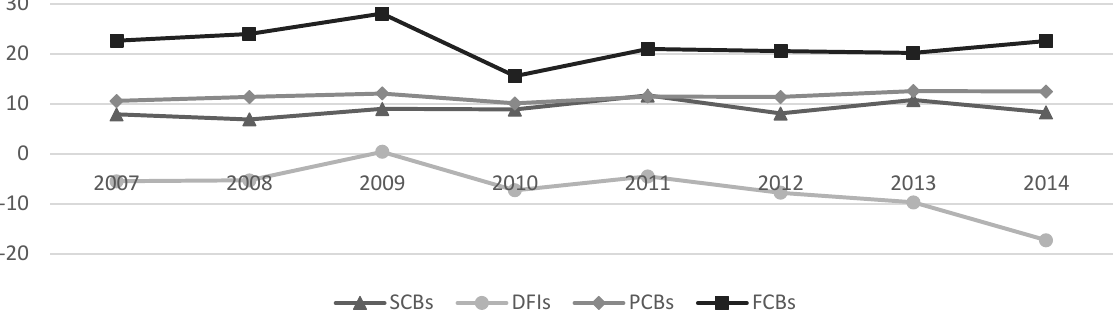
Figure 6. Comparative position of capital to risk weighted assets ratio by type of banks